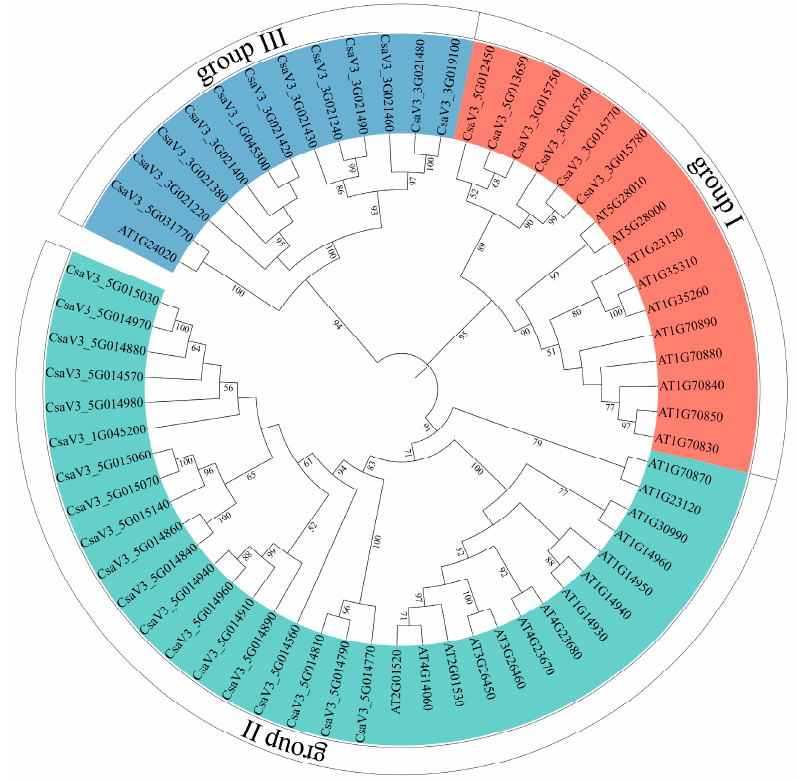
Figure 2. Phylogenetic relationship of MLP proteins from cucumber and Arabidopsis thaliana . The number on the branch indicates the bootstrap value.